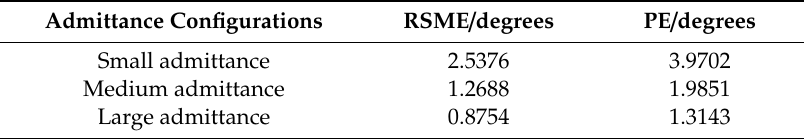
Table 5. Experimental results under di ff erent admittance